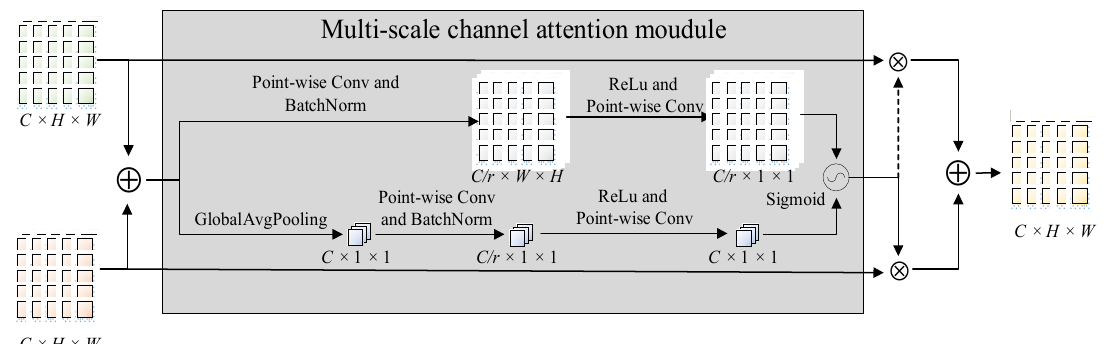
Figure 4. Structure of the improved transformer encoder (TE).